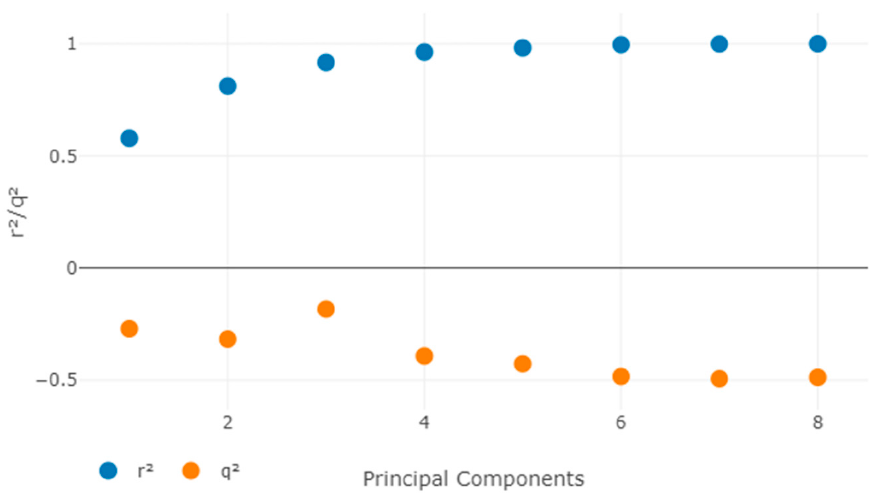
Figure 4. Alignment map of least active compounds .